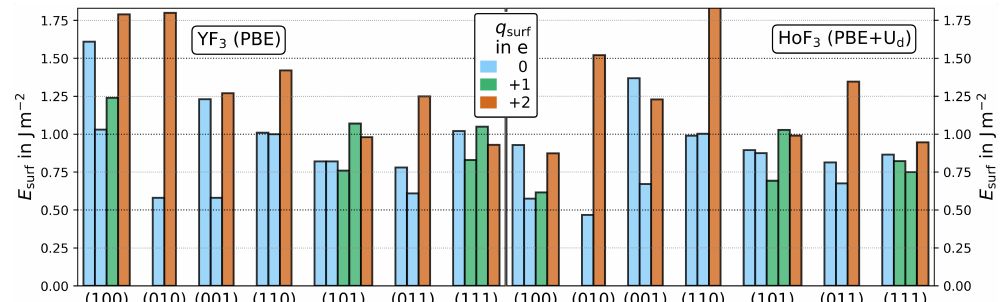
Figure 3. Relaxed surface energies of YF 3 (left, PBE) and HoF 3 (right, PBE+U d /3 eV/4f-in-core) of all 24 terminations. The surfaces are color-coded to their nominal surface net charge ( q surf ) in e of 0 (blue), + 1 (green) or + 2 (orange). This magnified plot does not show the HoF 3 (110)-3 value of 2.09 Jm − 2 .